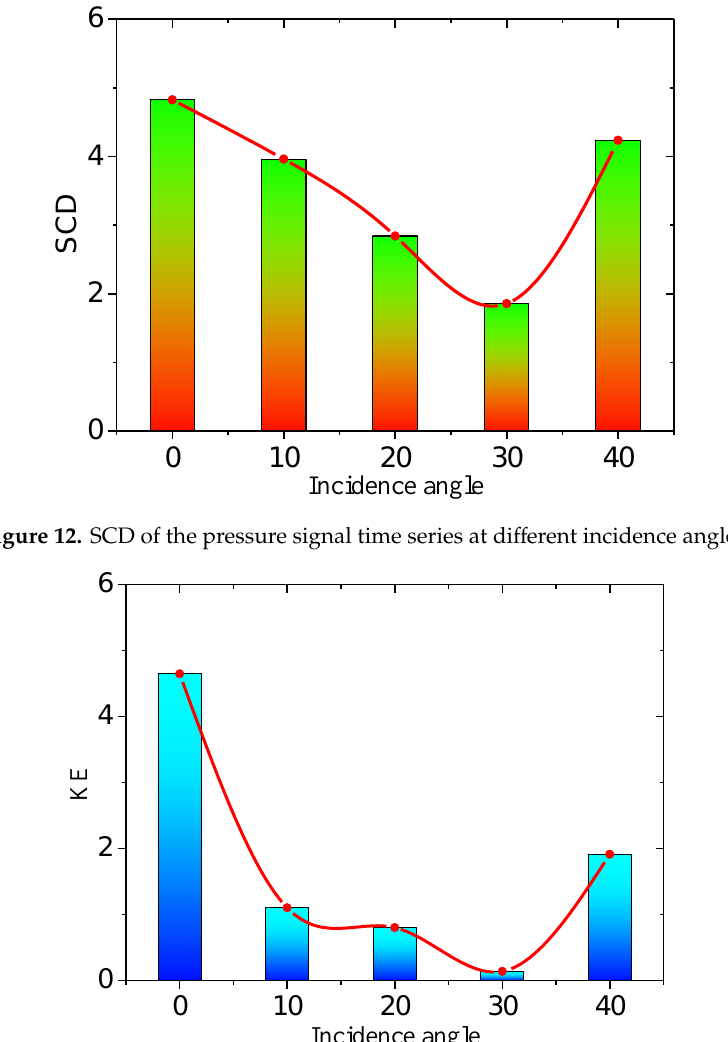
Figure 13. KE of the pressure signal time series at different incidence angles.